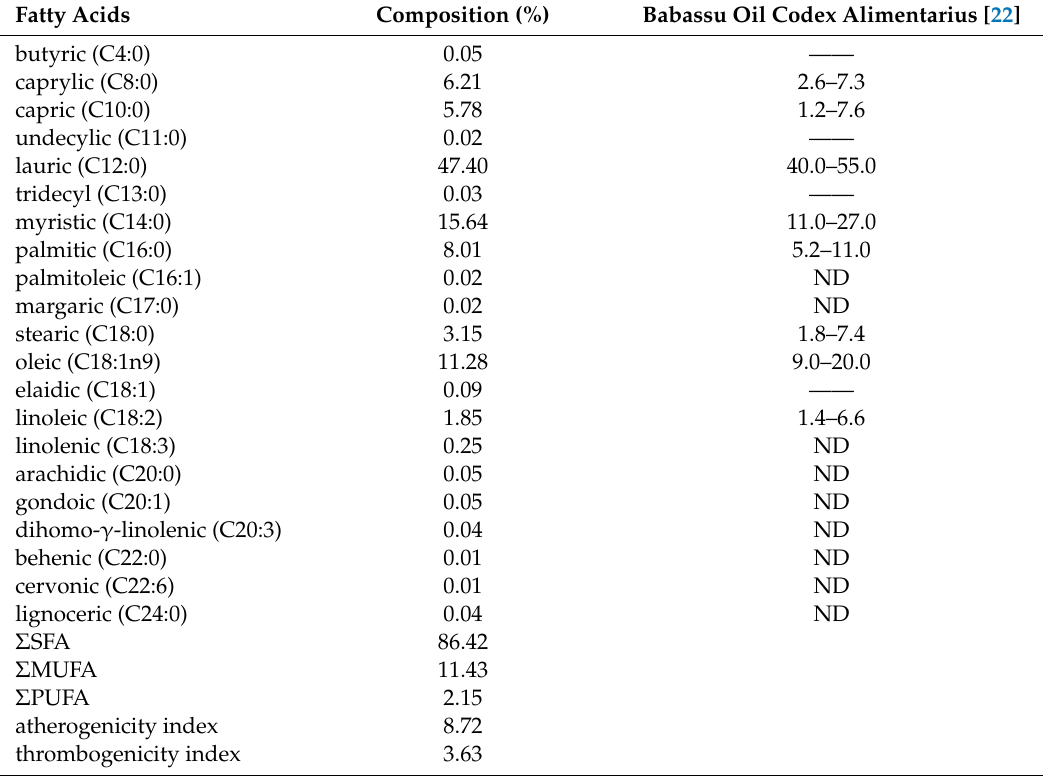
Table 1. Fatty acid profile of babassu oil obtained in this study compared to the Codex Alimentarius parameter for babassu